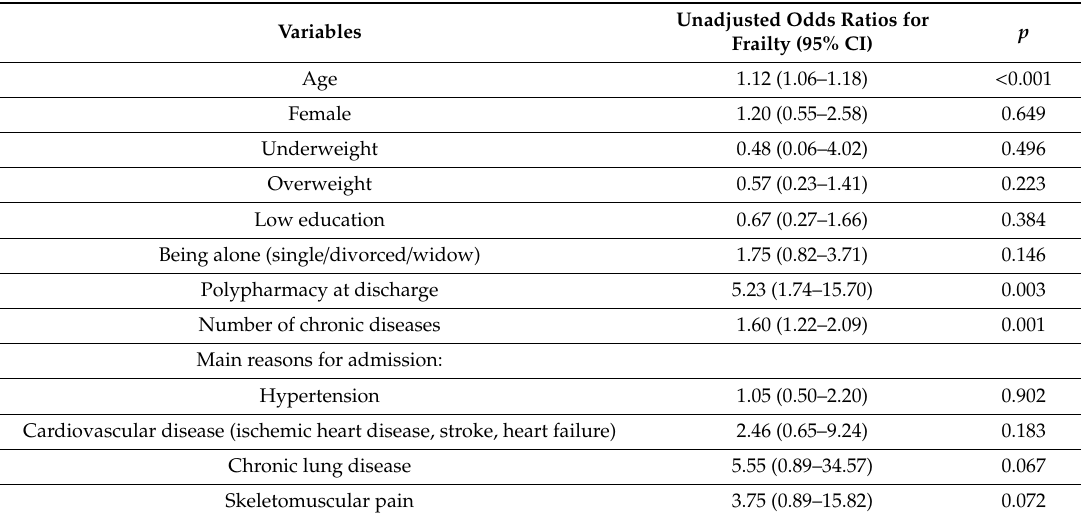
Table 2. Univariate logistic regression of potential associated factors for frailty transition among participants who were pre-frail before discharge ( n = 160).